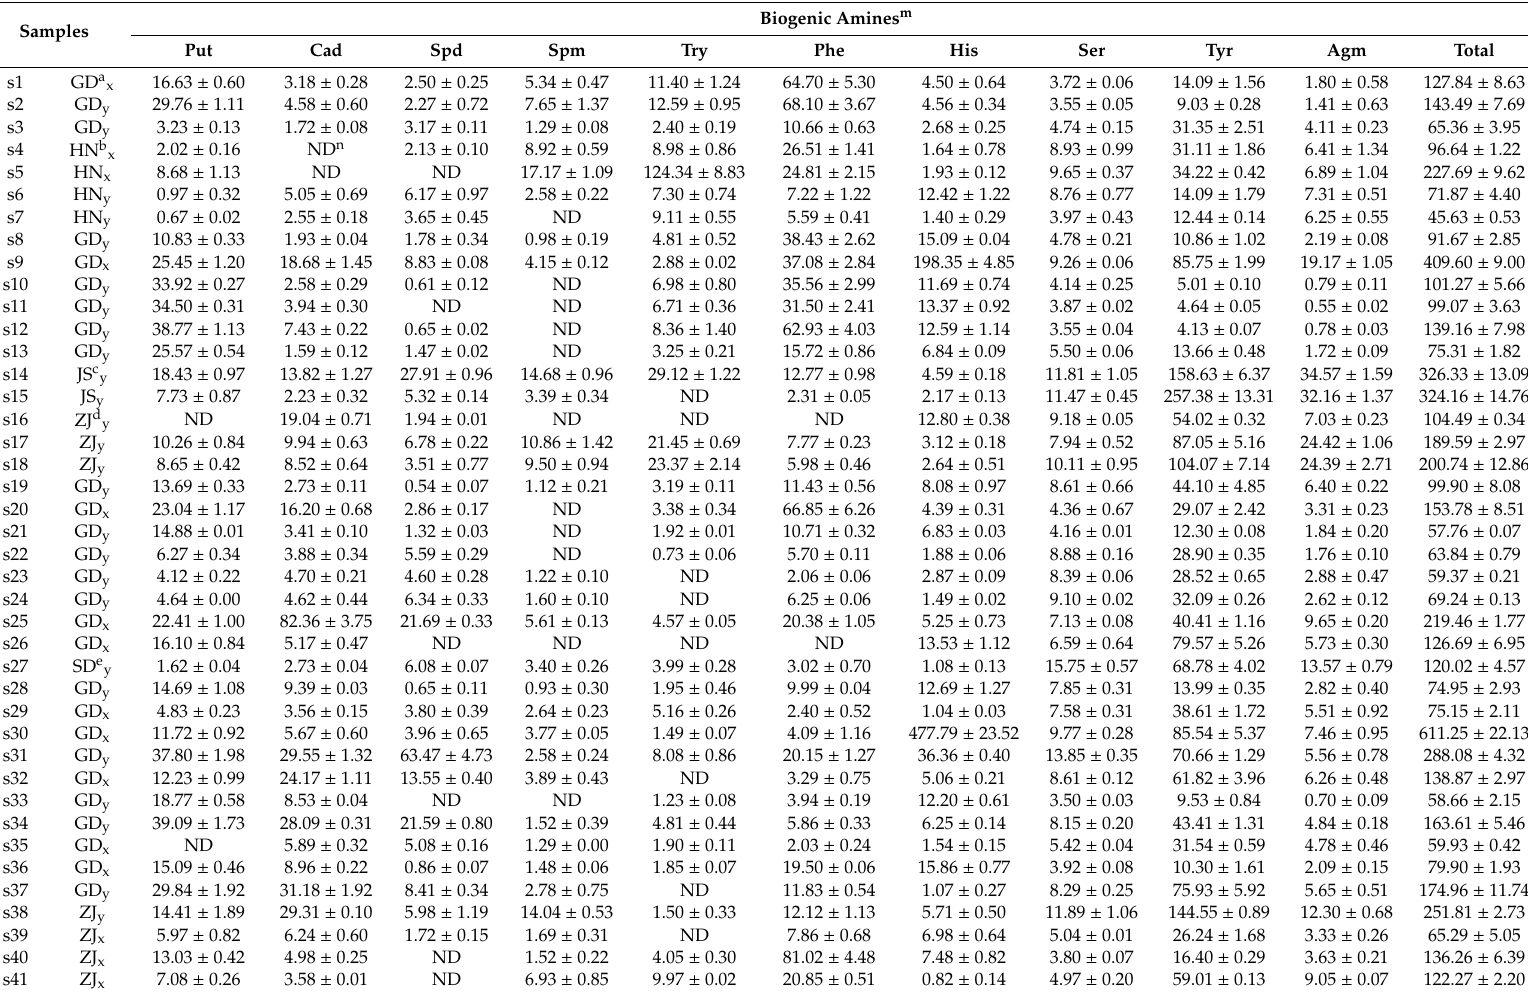
Table 3. Biogenic amine content in Chinese soy sauce from the